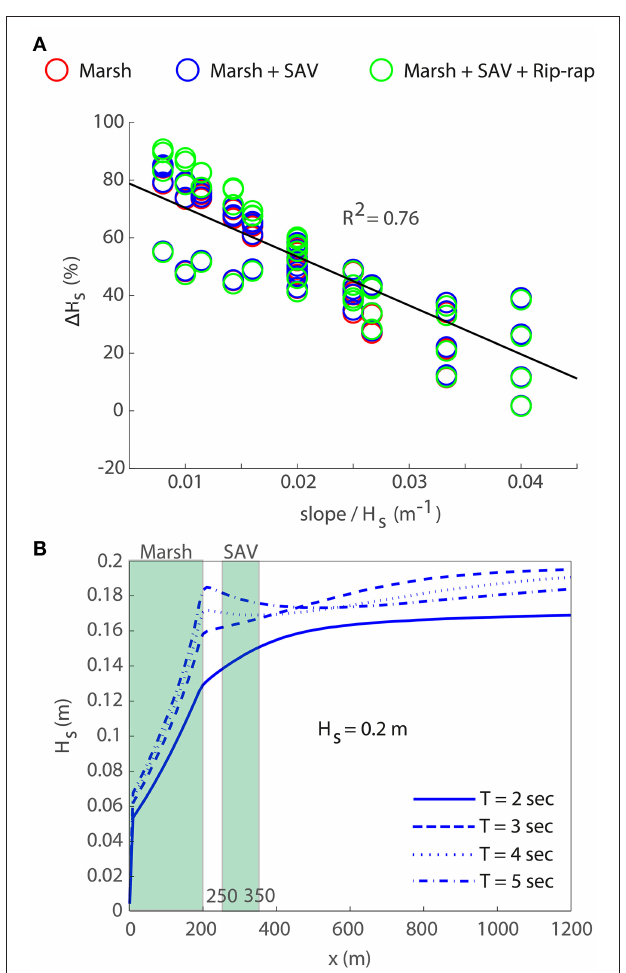
FIGURE 6 | (A) The wave damping for all runs as a function of the variable slope/Hs . (B) Example of wave damping for the configuration with marsh and SAV, slope 0.8%. =